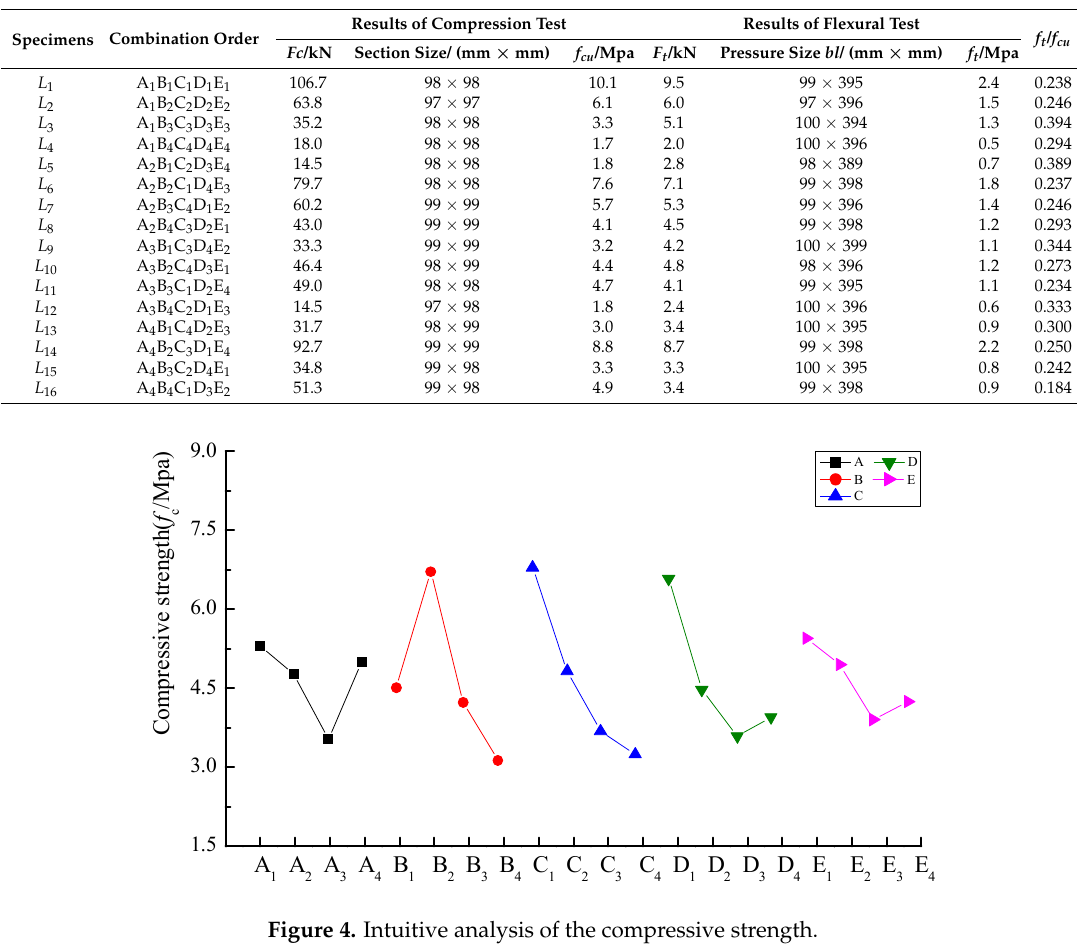
Table 5. Results of the compression test and the flexural test.